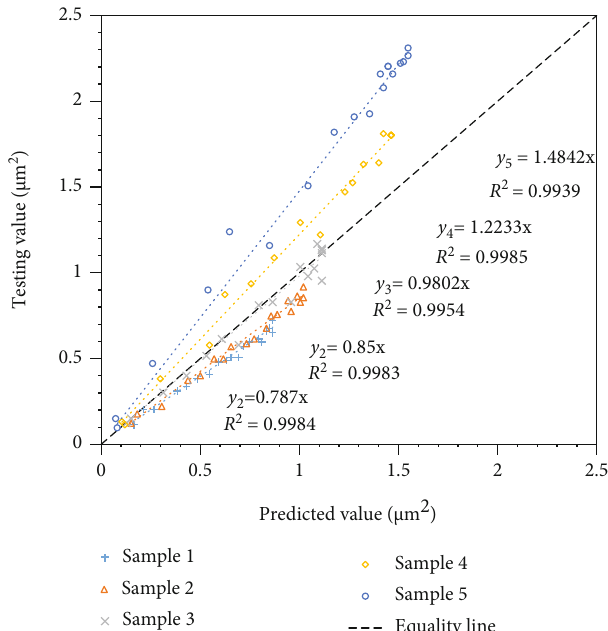
Figure 11: The linear relationship between the testing and predicted results of permeability by Carman-Kozeny model.